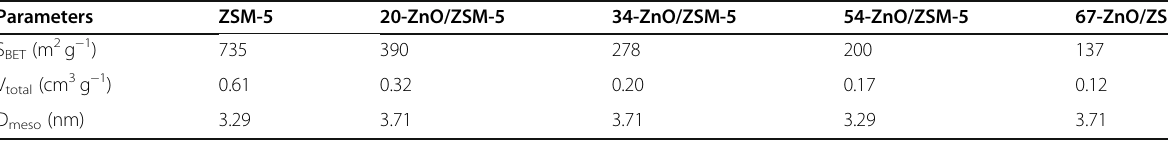
Table 2 Textural properties of ZSM-5 and ZnO/ZSM-5